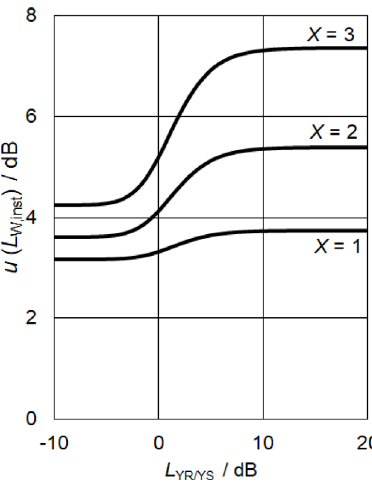
Figure 22. Uncertainty of the installed sound power level with assumed uncertainties u ( L Re( YR ) ) = u ( L ( YR / YS ) ) = X dB.